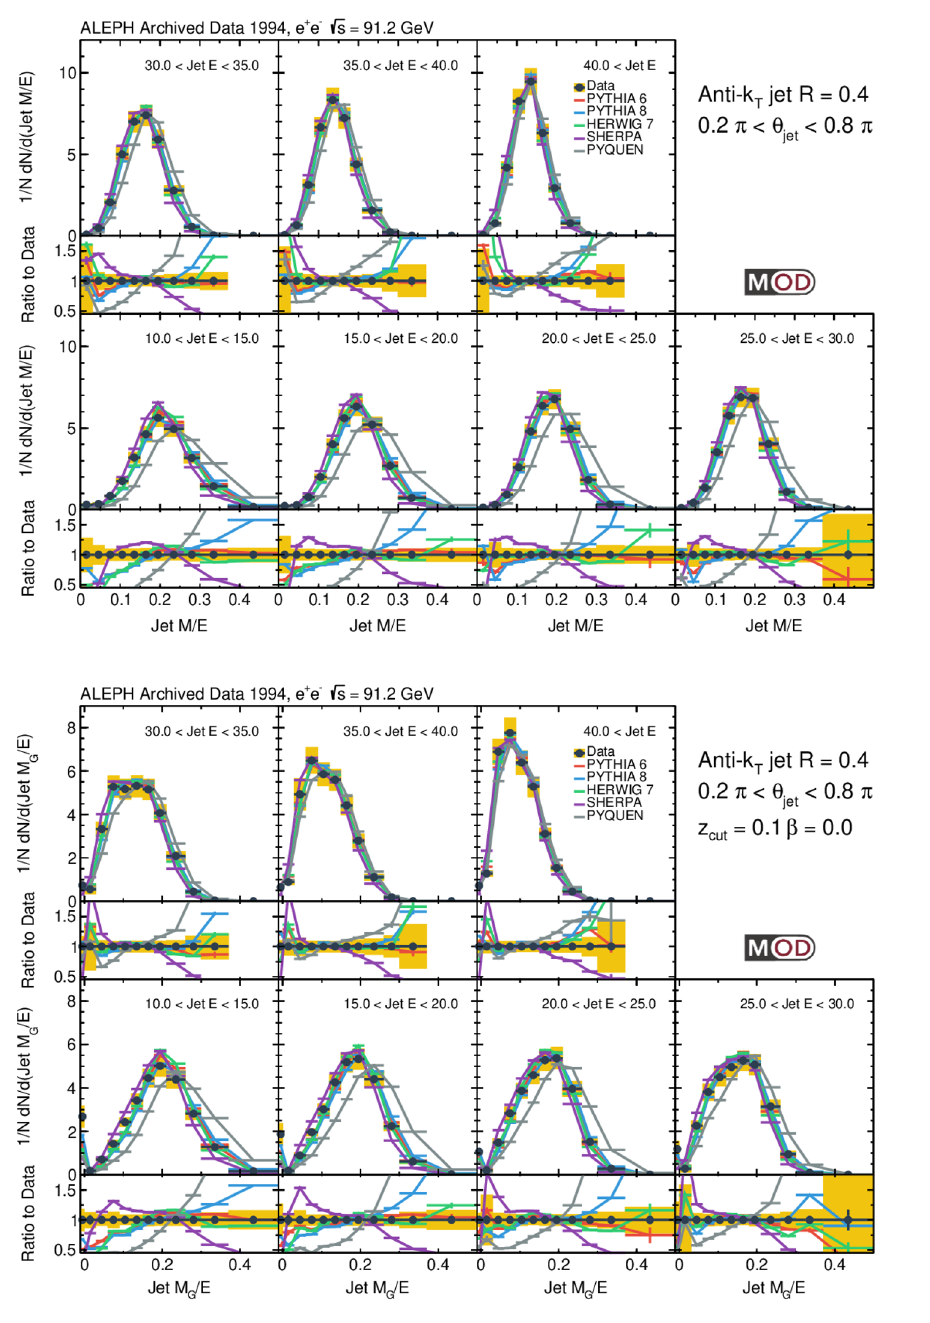
Figure 17 . Measured M/E and M G /E spectra in bins of jet E . The spectrum is self-normalized for each E interval. The fraction of jets completely groomed away are included in the first bin of each panel. The data is also compared with predictions from Pythia 6 (red), Pythia 8 (blue), Herwig (green), and Sherpa (purple)